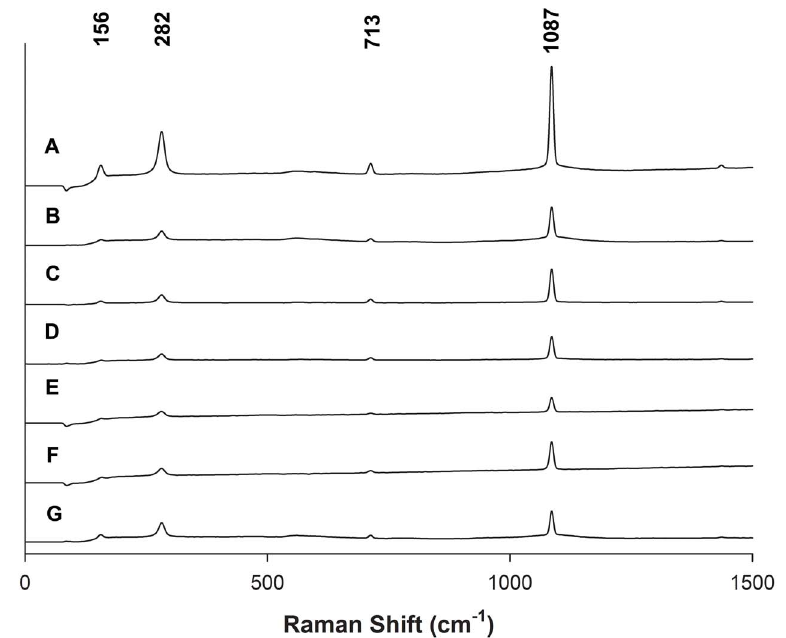
Figure 5. Polymorph determination of calcium carbonate crystals modified by rhOtolin-1 alone or in combination with rmOC90. Varying concentrations of rhOtolin-1 or rmOC90 protein, (A and B) 1000 nM rmOC90; (C and D) 667 nM rhOtolin-1; (E and F) 667 nM rhOtolin-1plus 500 nM rmOC90; (G) pure growth solution were dissolved in 7.5 mM CaCl 2 growth solution and crystals were grown for 48 hours by slow evaporation of NH 4 HCO 3 into growth solution. Raman spectra were collected on pre-selected crystals of CaCO 3 with a HoloLab 5000 Raman microprobe spectrometer system.